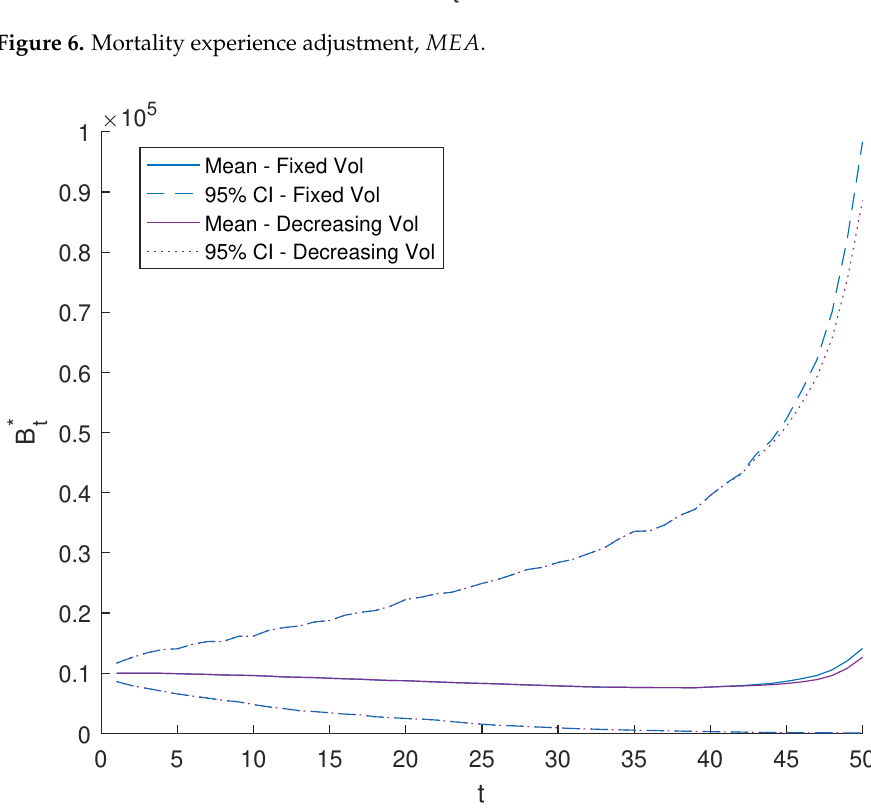
Figure 7. Fixed Volatility vs. “Trend Down”